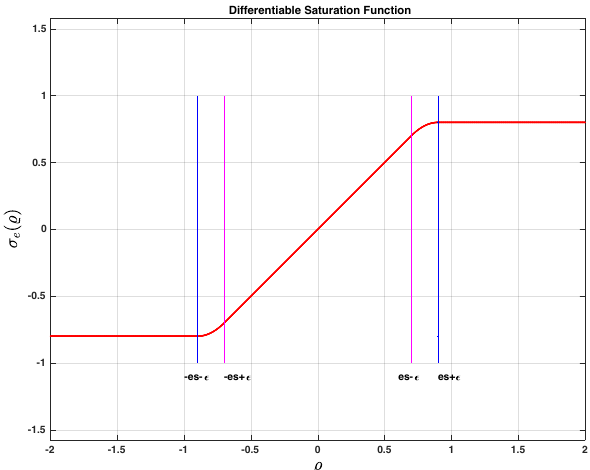
Figure 6. Differentiable saturation